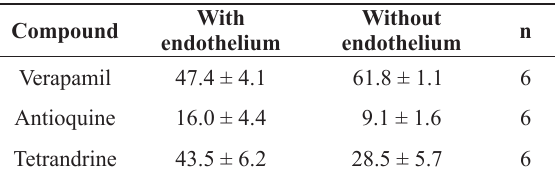
It shows the three compounds studied (tetrandrine, antioquine and verapamil) in rat aorta with (presence of endothelium) and without (absence of endothelium) in phase 2 of the contraction. The blocking effect of verapamil compared to tetrandrine in the presence of endotelium is similar (there is no significant difference) but it is significative in the absence of endothelium, but with a lower tetrandrine